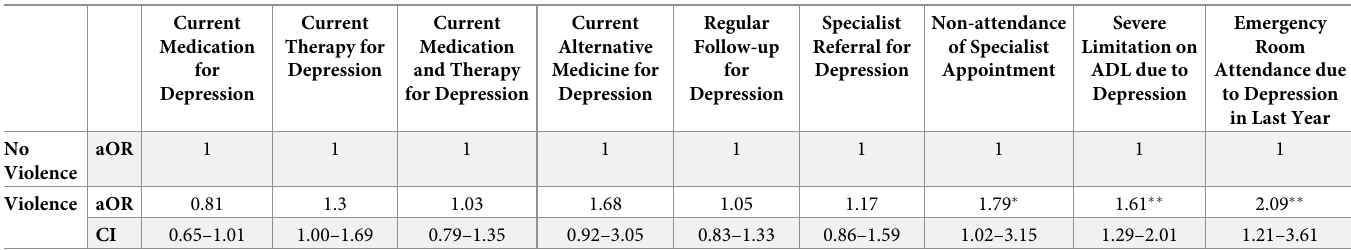
Table 5. Results from logistic regression models assessing associations between depression treatments and characteristics, and experiencing